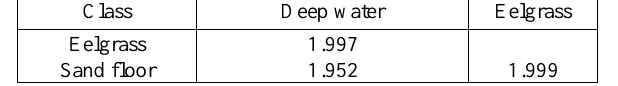
Figure 3. Mean value of the vegetation indices computed with the WV-2 band images as a function of the